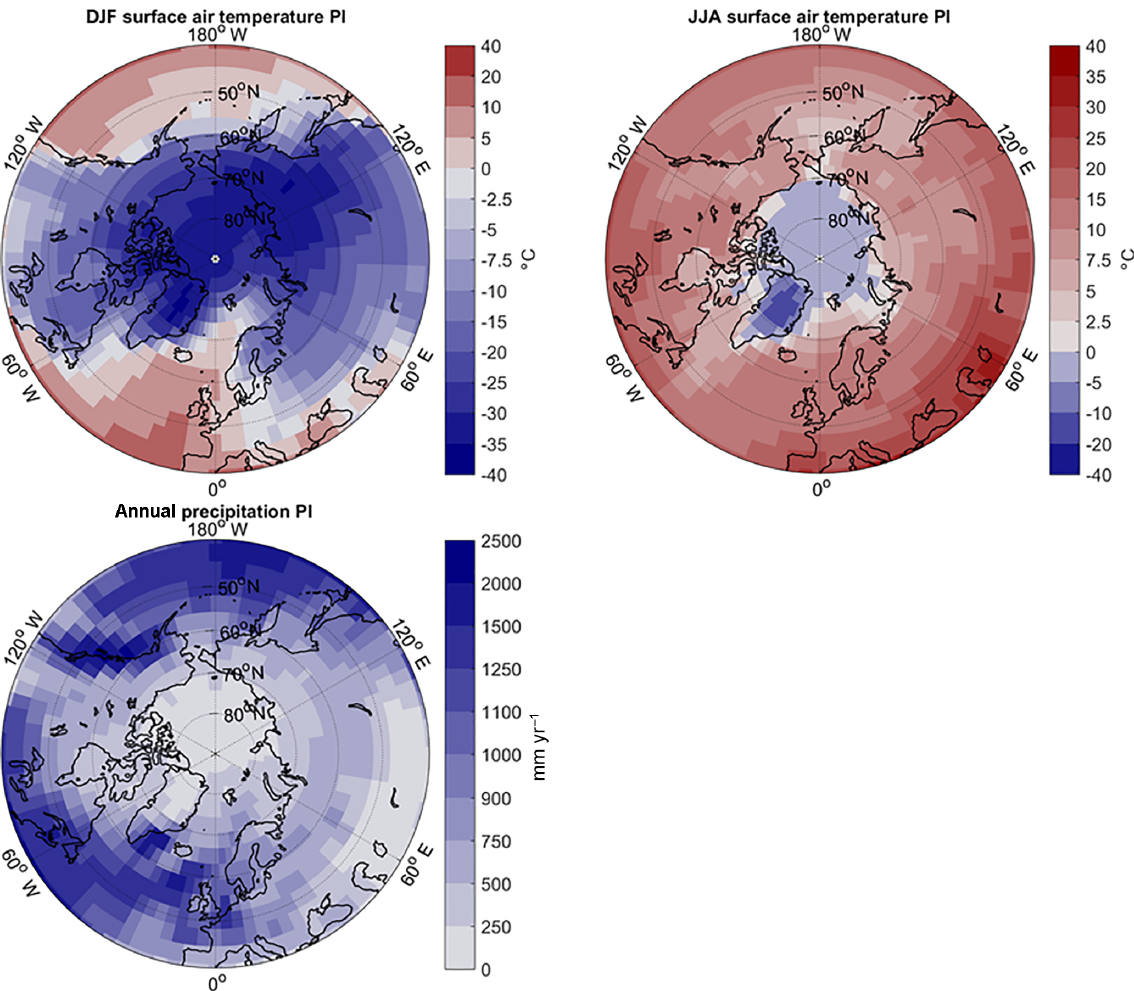
Figure A3. PI winter surface air temperatures (DJF), summer surface air temperature (JJA), and annual precipitation simulated by MPI-